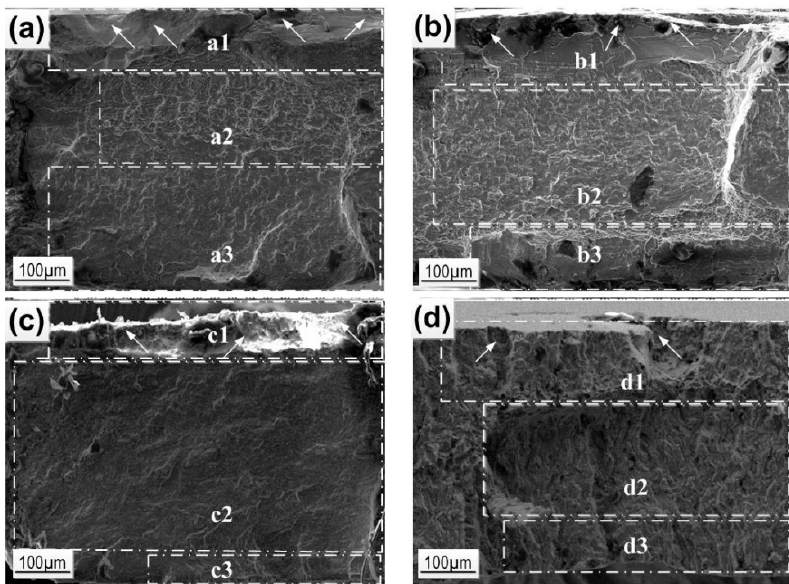
Figure 7. SEM images of ( a ) 18-14, ( b ) 18-13-1, ( c ) 18-15, and ( d ) Ti Grade2 fracture surfaces after mechanocycling in Hanks’ solution: (1) fatigue crack initiation area, (2) the crack propagation area, and (3) mechanical rupture area; arrows indicate the crack initiation points [34].